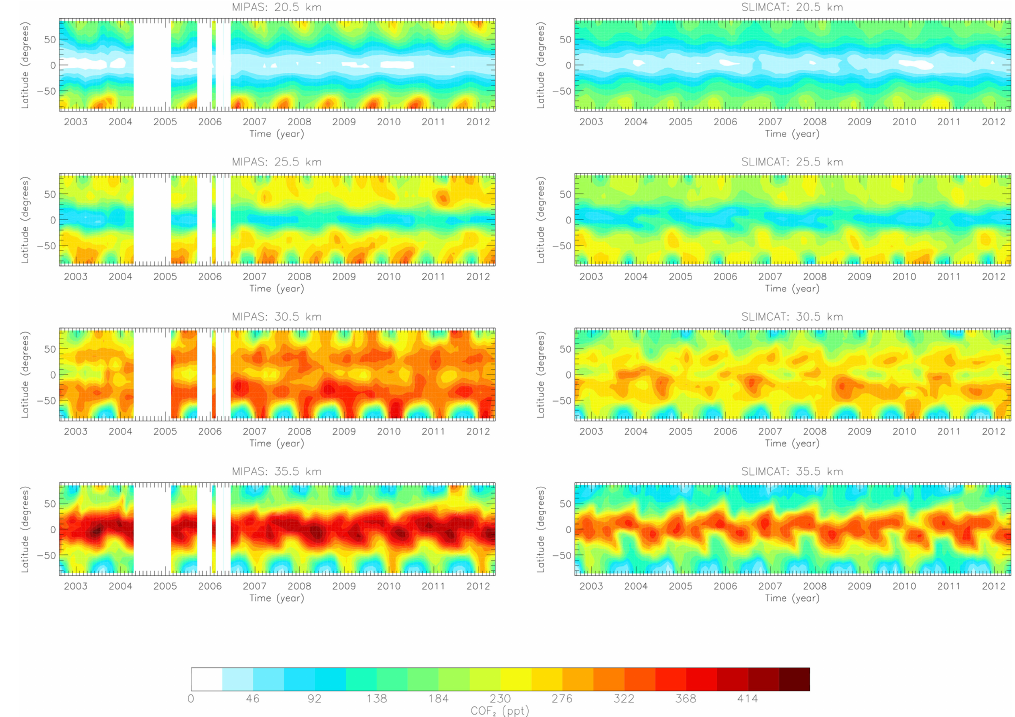
Figure 12. The MIPAS and SLIMCAT COF 2 time series between July 2002 and April 2012 for all latitudes at selected